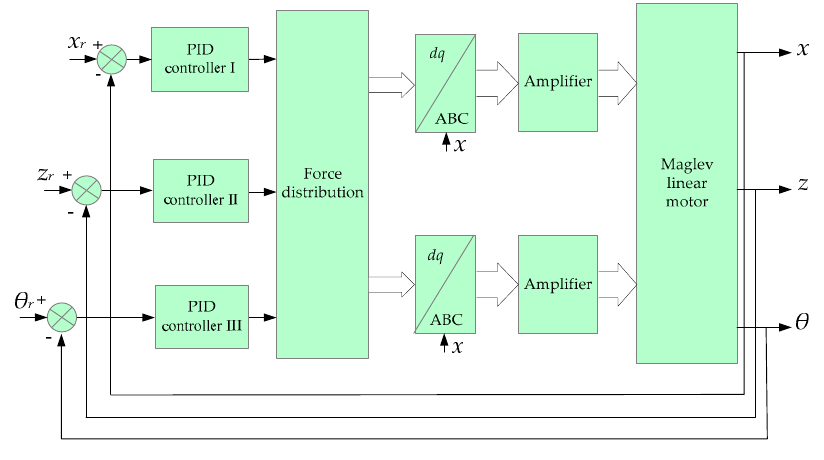
Figure 12. Control system structure. Table 3. Proportional-integral-derivative (PID) controller parameters.